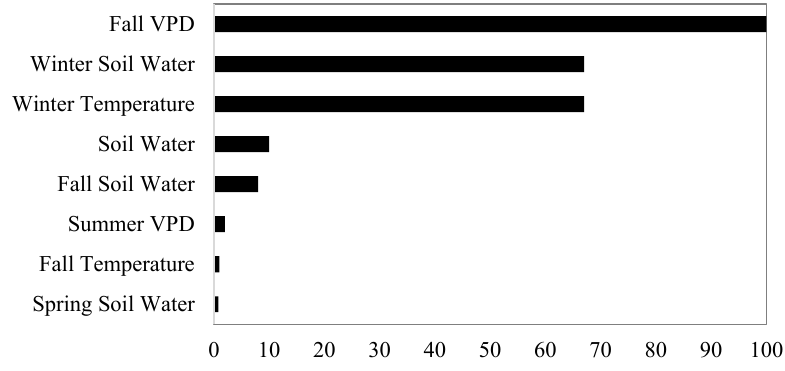
Figure 3. Overall importance (%) of 3-PG climatic